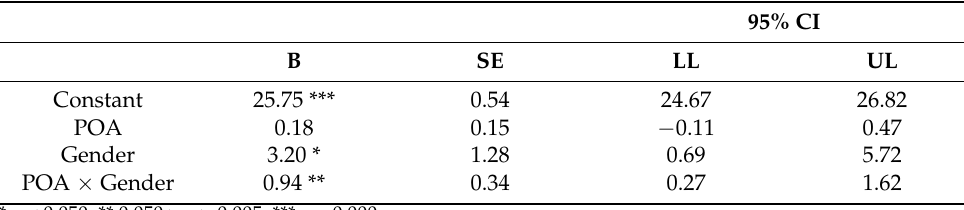
Table 12. Unstandardized regression coefficients for Model